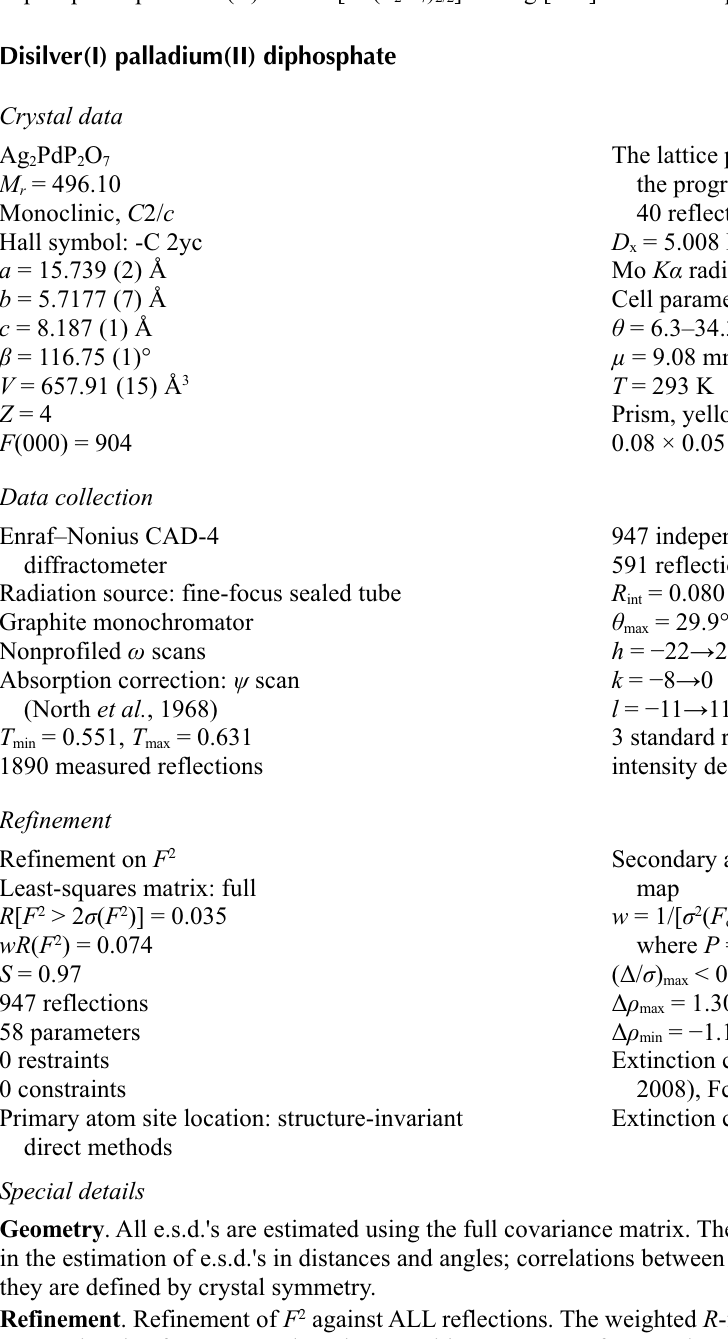
O ) ] 2- along [001]. Thermal elipsoids with 50% probability ( DIAMOND , v3.1f). 2 7 2/2